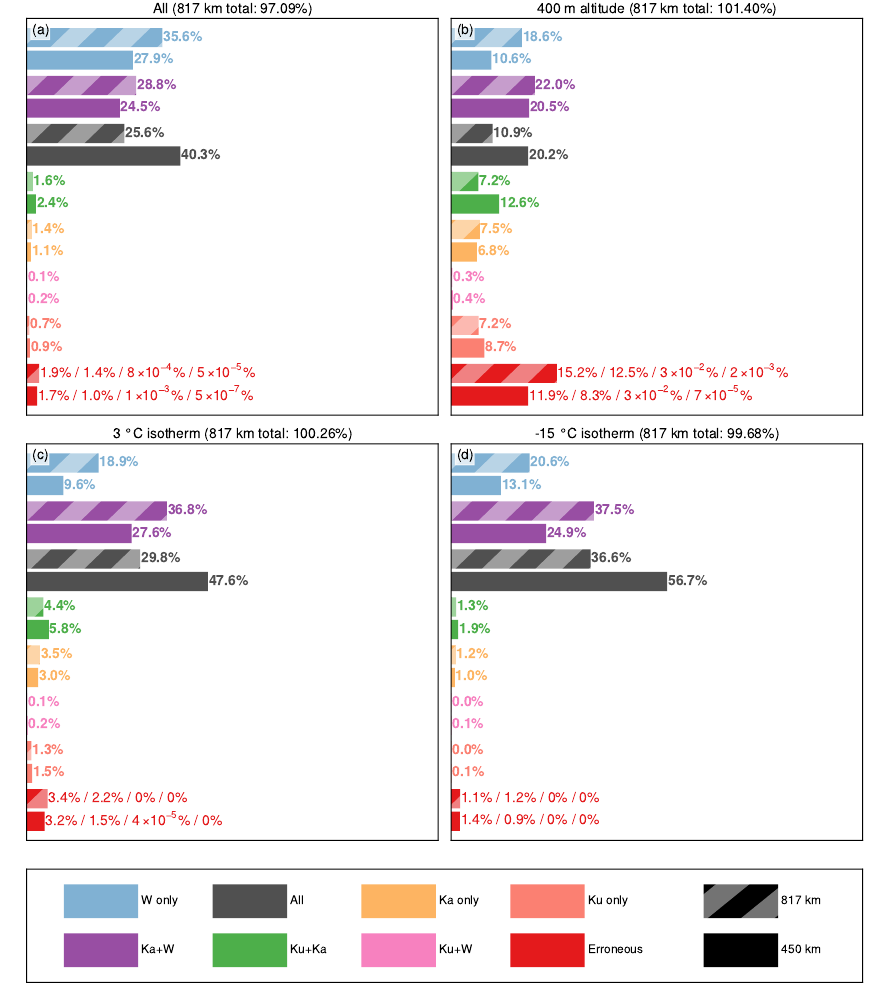
Figure 7. As in Fig. 4, but limited to the region of Fig. 6 (Sect. 5.2; TMC in Fig. 3).